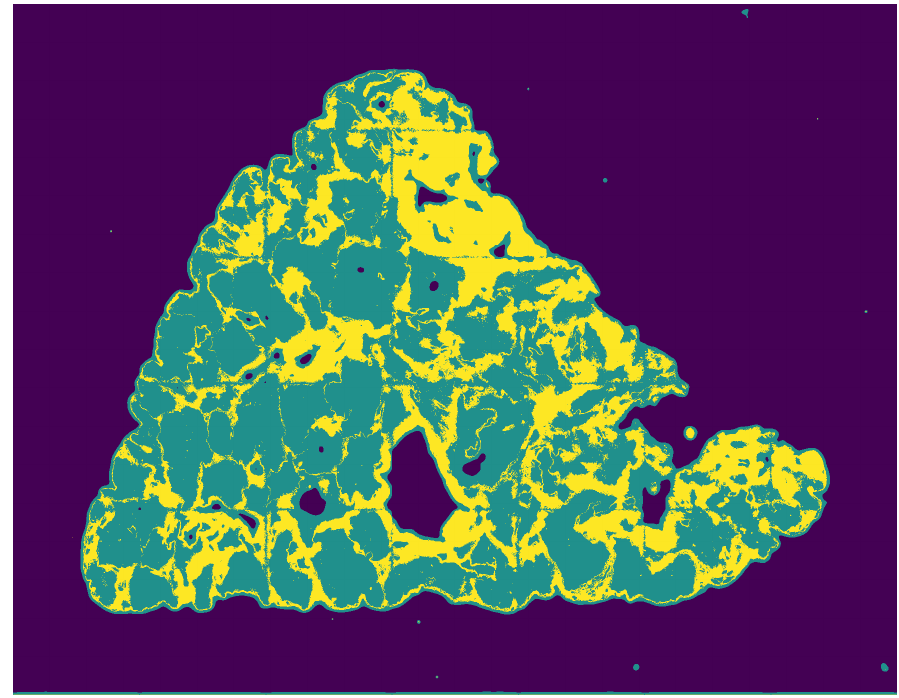
Figure 5. Output of the handcrafted texture feature-based segmentation. The background class is in dark purple, the intralobular area is represented by teal color, and the extralobular area is in